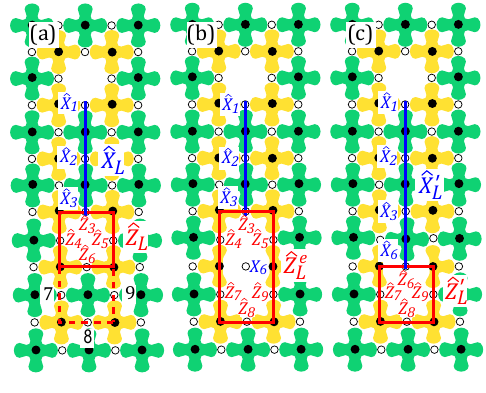
Figure 33: Moving a Z-cut logical qubit hole down by one cell. (a) Logical qubit with = X X X X and Z L 1 2 3 below the lower qubit hole: Z e